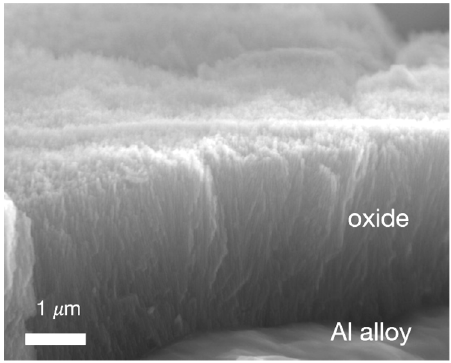
Figure 9. Example of a cross-section of an anodic aluminum oxide prepared by PSA anodizing (Vrije Universiteit Brussel). (Vrije Universiteit